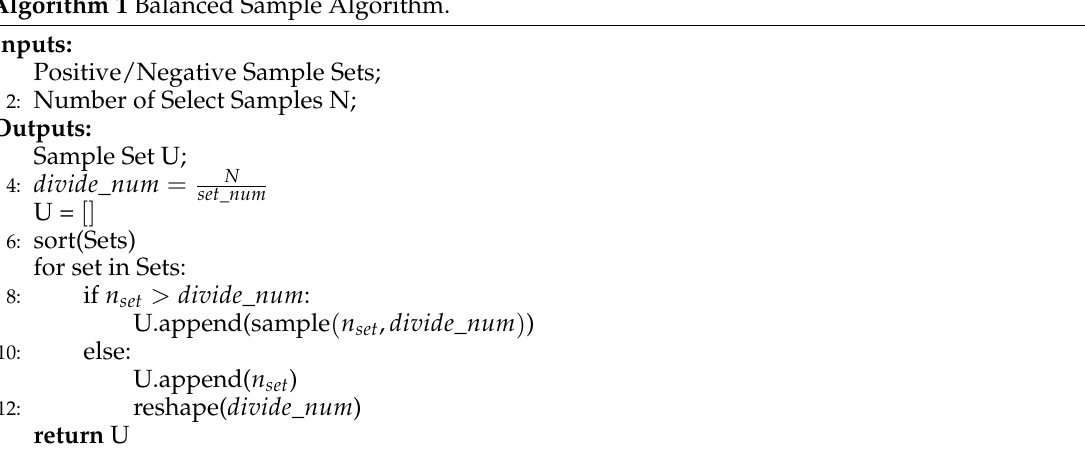
Algorithm 1 Balanced Sample